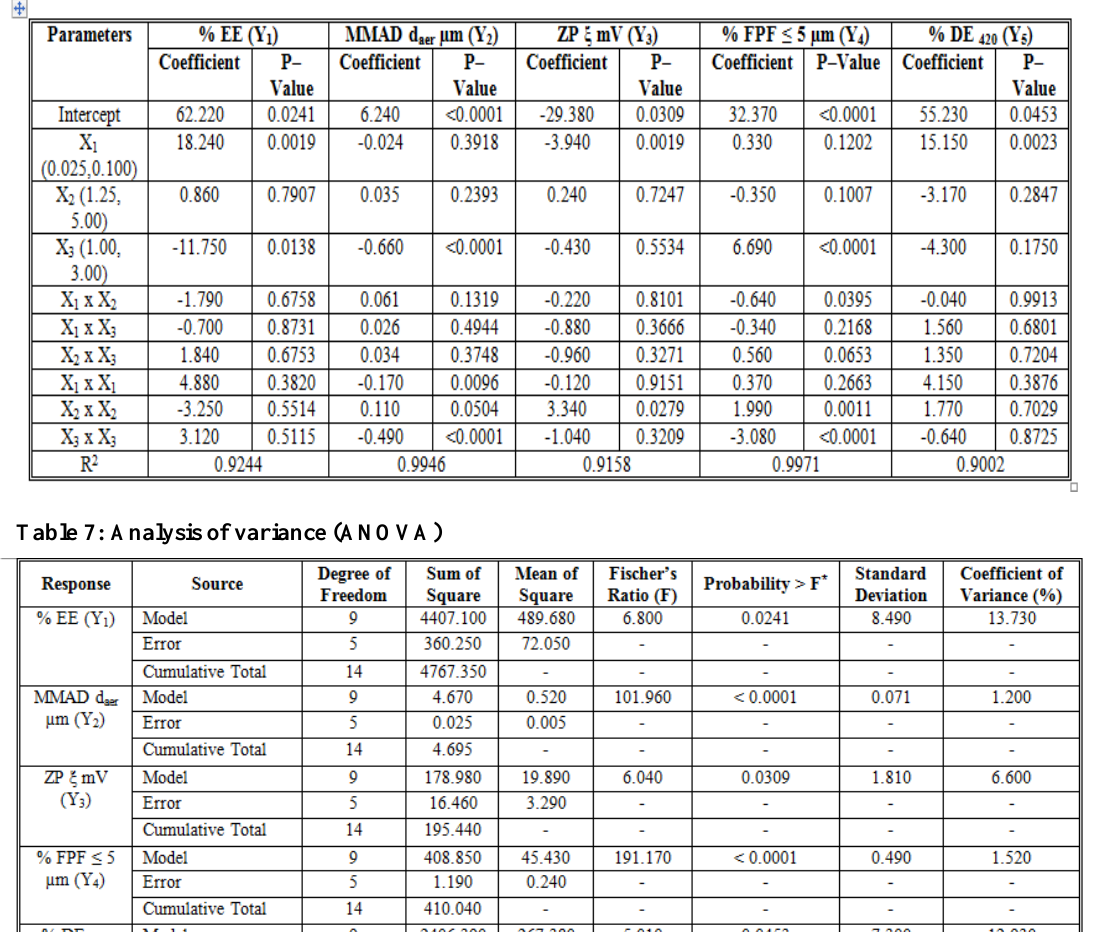
Table 6: Statistical regression analysis